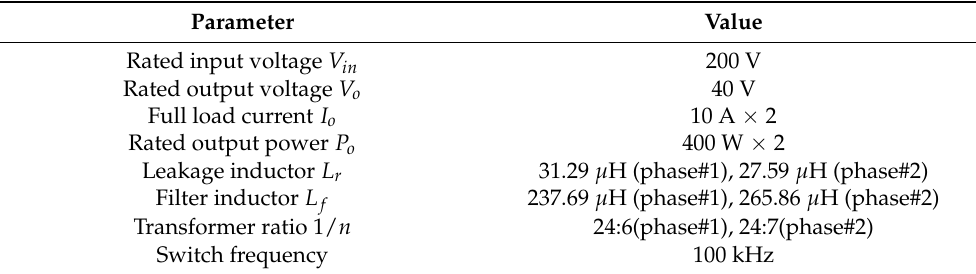
Figure 21. Testing bench and prototype of two-phase PSFB converter: ( a ) testing bench; ( b ) prototype. Table 10. Prototype circuit component